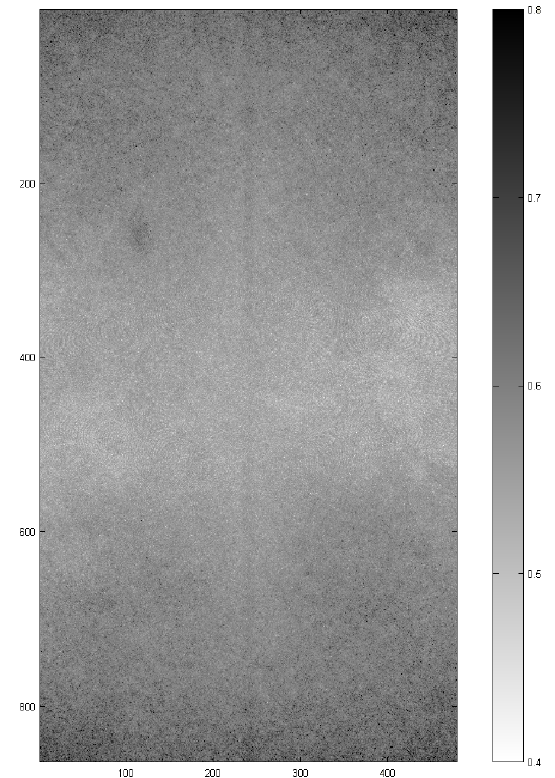
Figure 8: Sharpness image obtained through calibration for the airborne